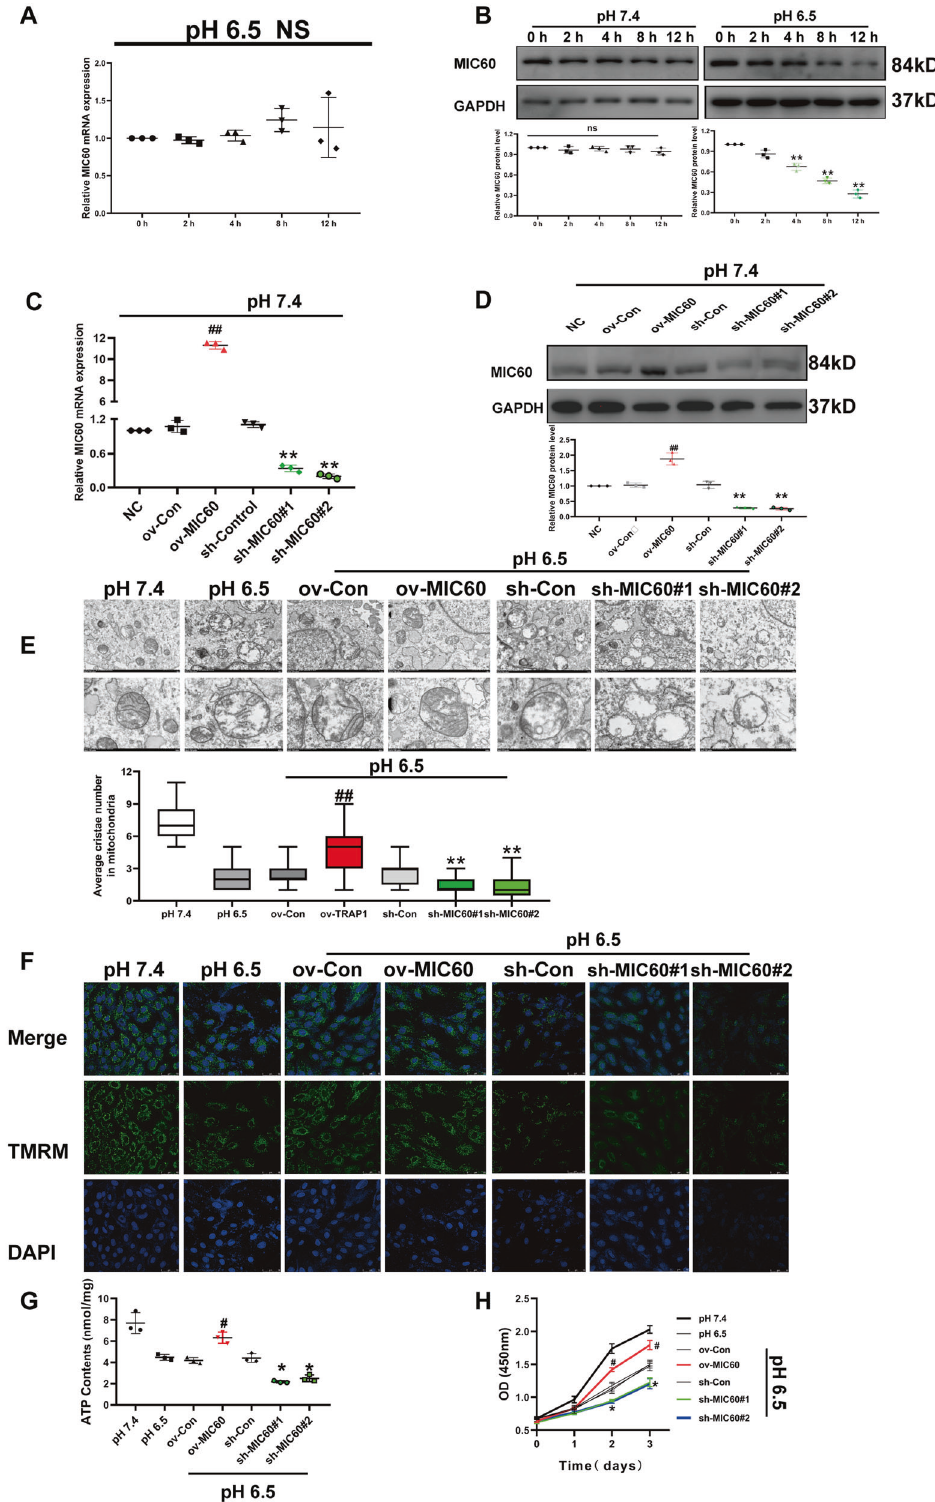
of H9C2 cells [16]. Mitochondrial cristae, on which mitochondrial respiratory chain-associated proteins were bound, is an important component of the mitochondrial inner membrane and very crucial for mitochondrial oxidative phosphorylation [33, 34]. Previous studies reported that mitochondrial cristae damage led to